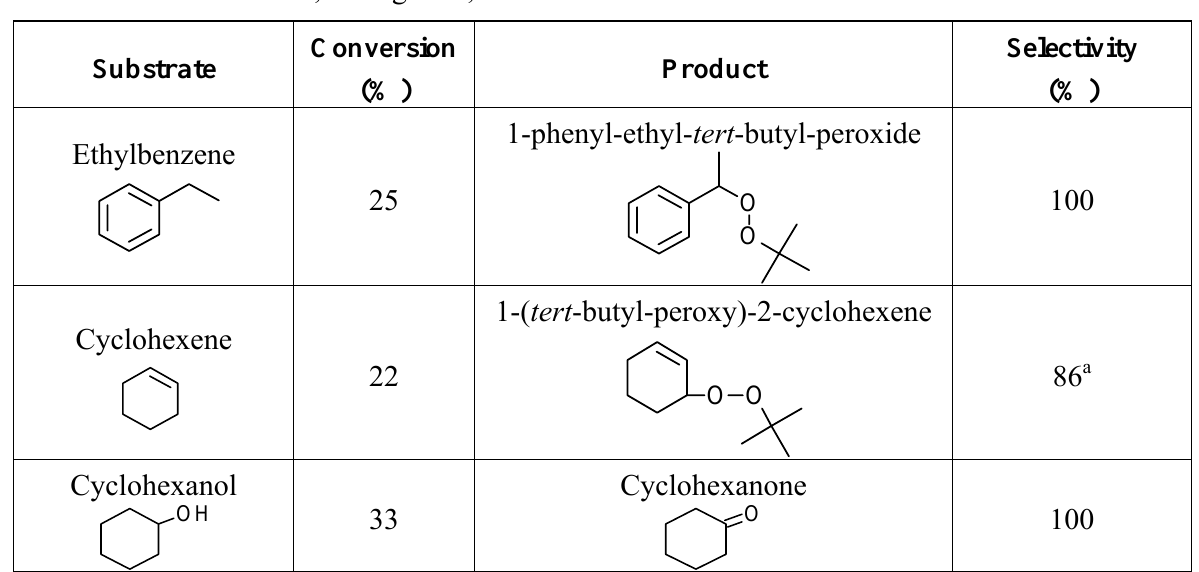
Table 3. Oxidation of different substrates with t-BuOOH, in the presence of CeNR, using acetonitrile as solvent, during 24 h, at 55